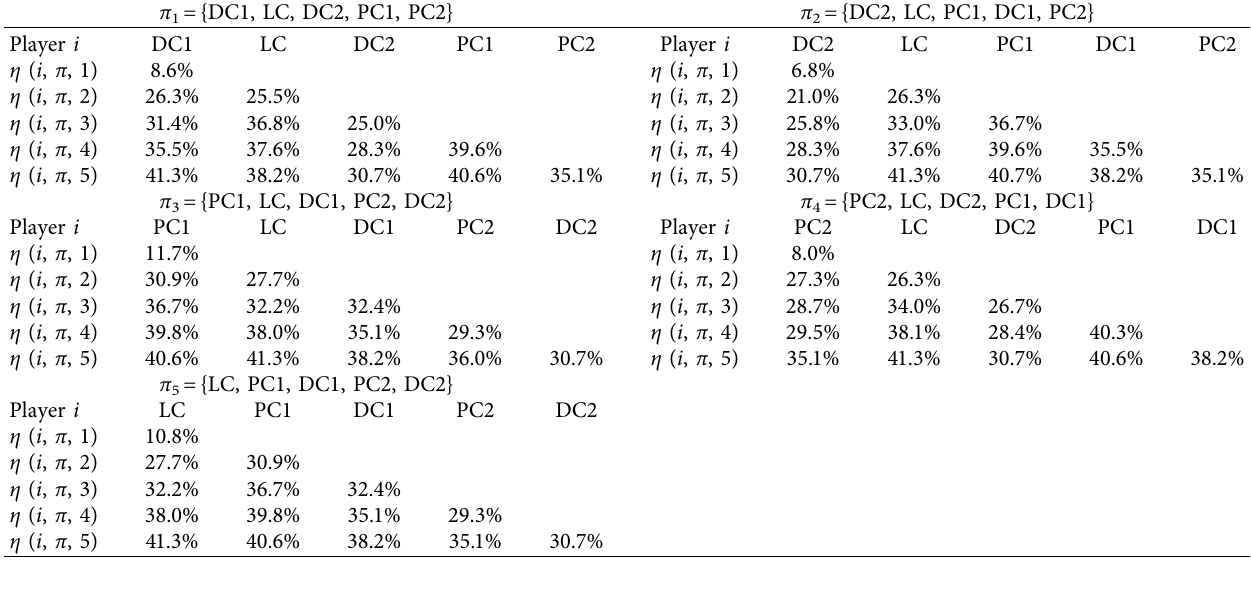
Table 11: Best coalition sequences satisfying SMP from each logistics facility.